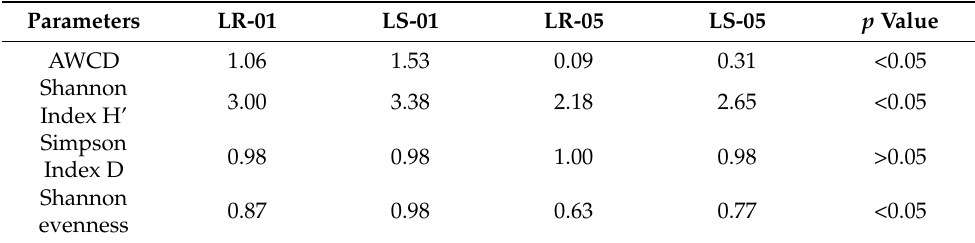
Figure 2. Changes in AWCD cure of all rock and soil samples according to different sample zones (LS1 and LR1, outside cave; LS5 and LR5, inside cave). N = negative control, P = positive control. Table 1. Substrate utilization diversity and evenness index among rock and soil samples according to the different sampling